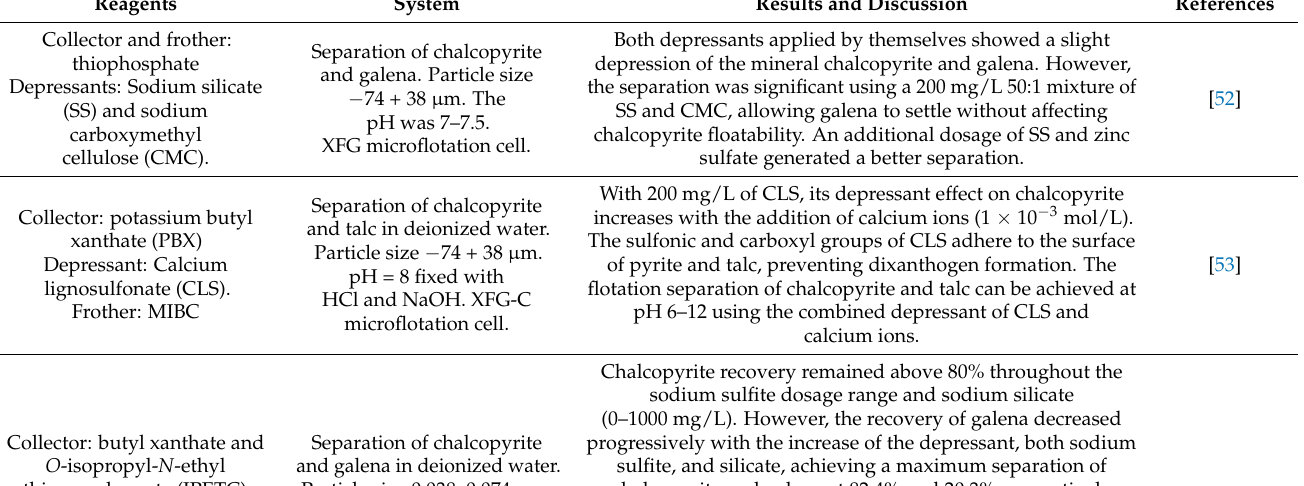
Table 1. Reagents used in the chalcopyrite